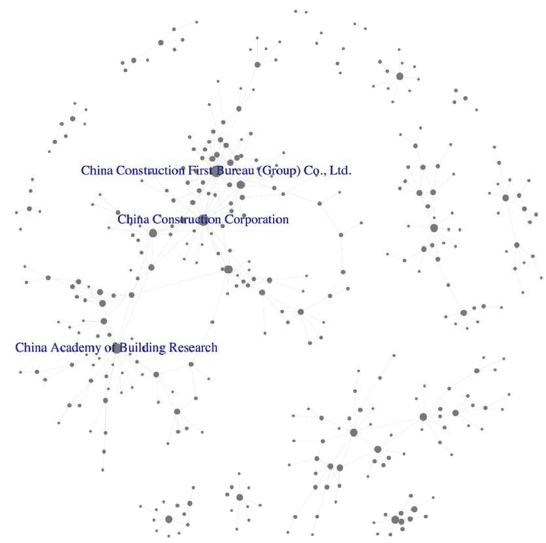
Figure 10: Community of construction industry with flat